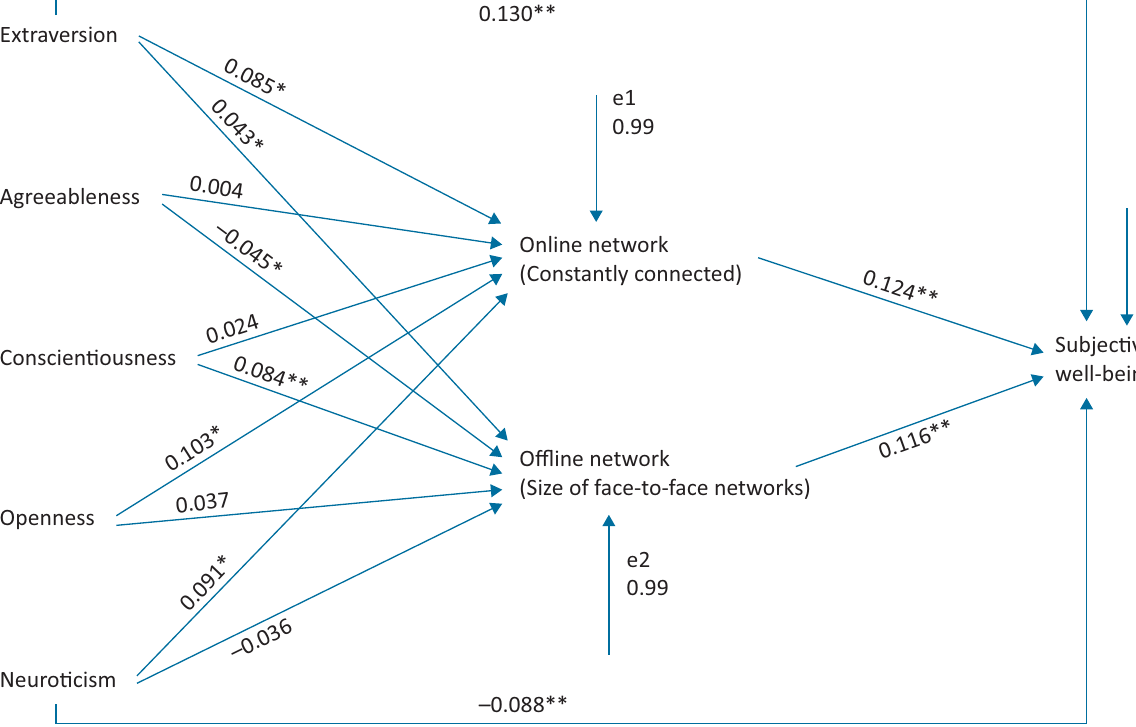
Figure 2. Causal model of subjective happiness. The structural equations have been constructed as follows: 1: Online net = x1 Extraversion + x2 Agreeableness + x3 Conscientiousness + x4 Openness + x5 Neuroticism + error 1; 2: Offline net = x1 Extraversion + x2 Agreeableness + x3 Conscientiousness + x4 Openness + x5 Neuroticism + error 2; 3: Happiness = x1 Extraversion + x2 Neuroticism + x3 Online net + x4 Offline net + error